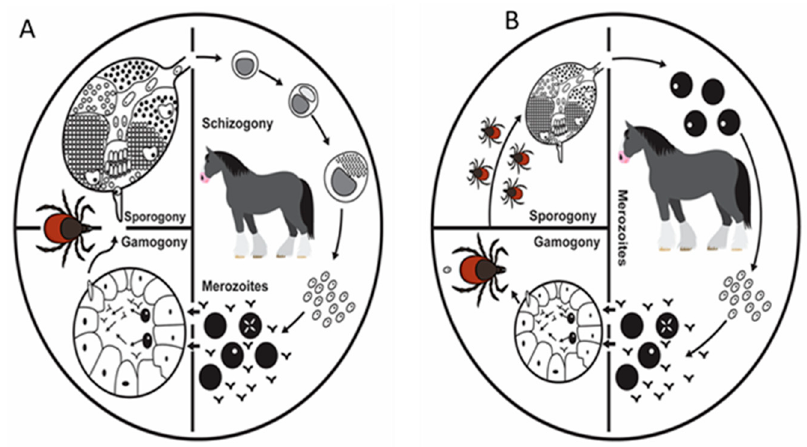
Figure 3. Schematic illustration of the life cycle of Theileria equi ( A ) and Babesia caballi ( B ) in the vertebrate host and invertebrate vector. Adopted from [23] with few modifications.